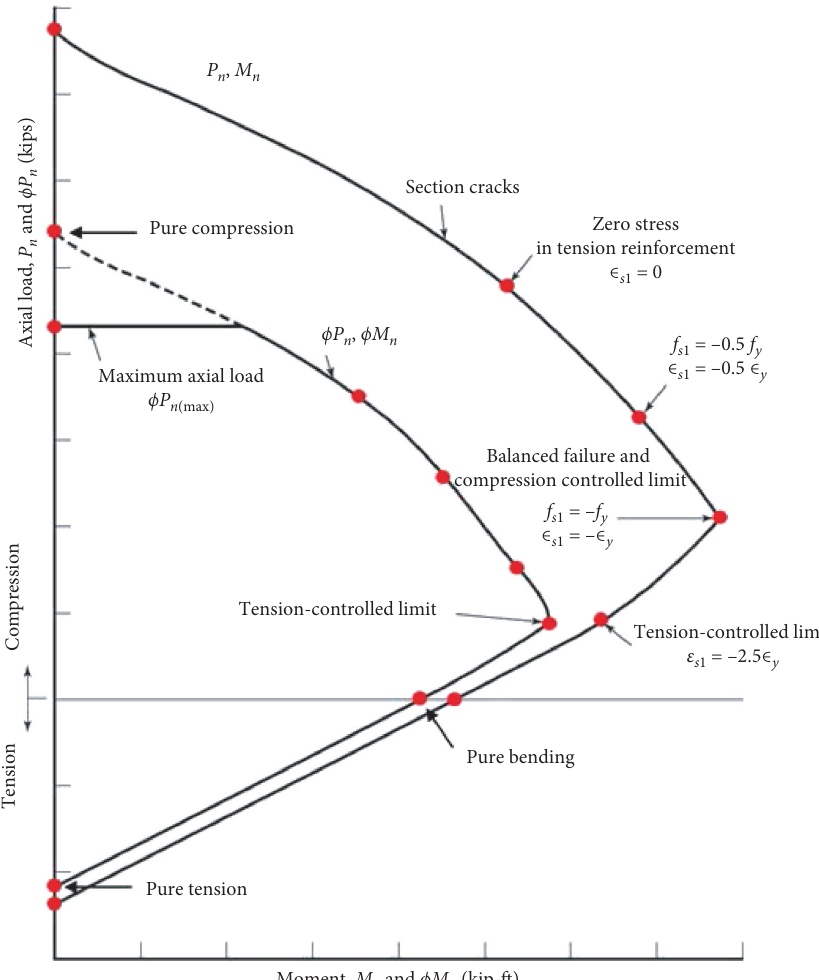
Figure 4: Control points for column interaction curve ( ∅ P